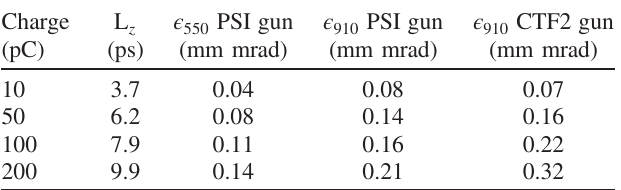
TABLE II. Slice emittance along the central 75% of the total bunch length at the end of the injector optimized at several charges assuming 550 nm = mm and 910 nm = mm as normalized intrinsic emittance. The values corresponding to the CDR design using the CFT2 gun are reported for comparison.